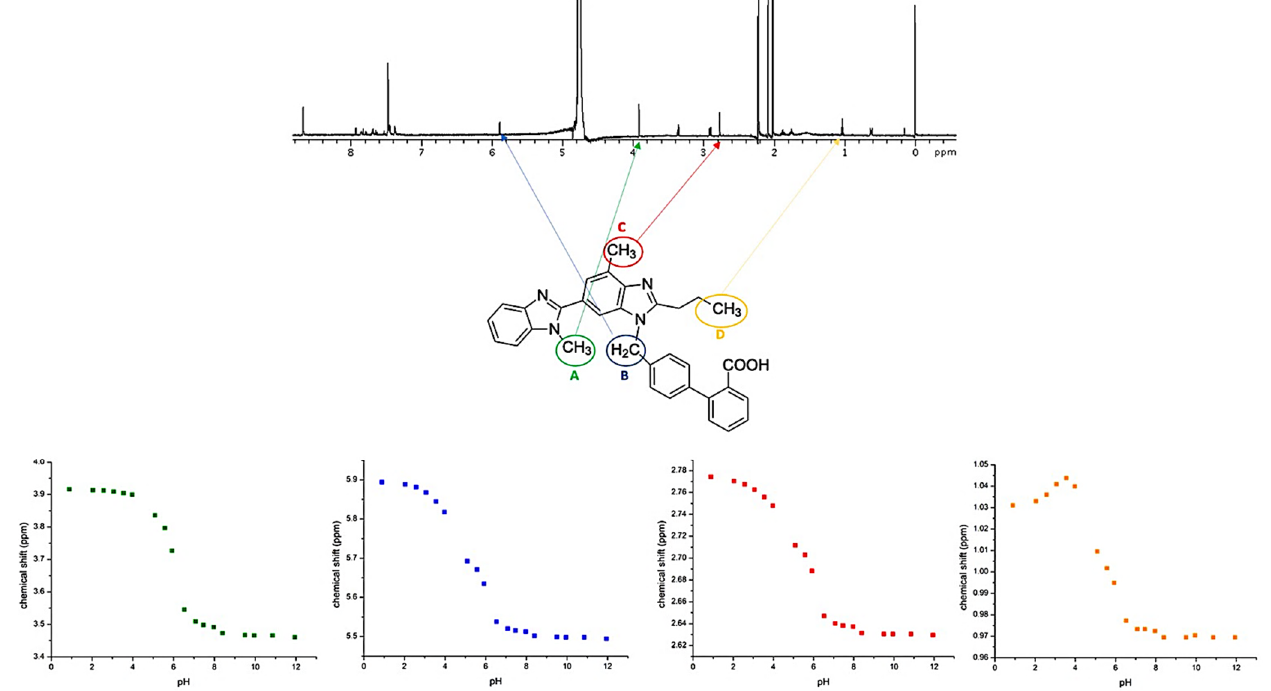
Figure 2. 1 H NMR spectrum( top ) and 1 H NMR pH-titration curves ( bottom ) of telmisartan.